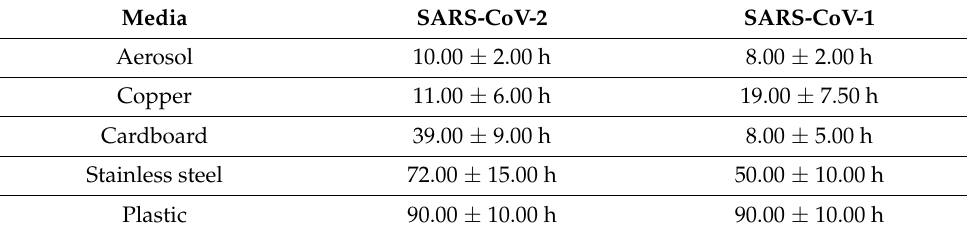
Table 2. Estimated critical periods for SARS-CoV to remain active on several